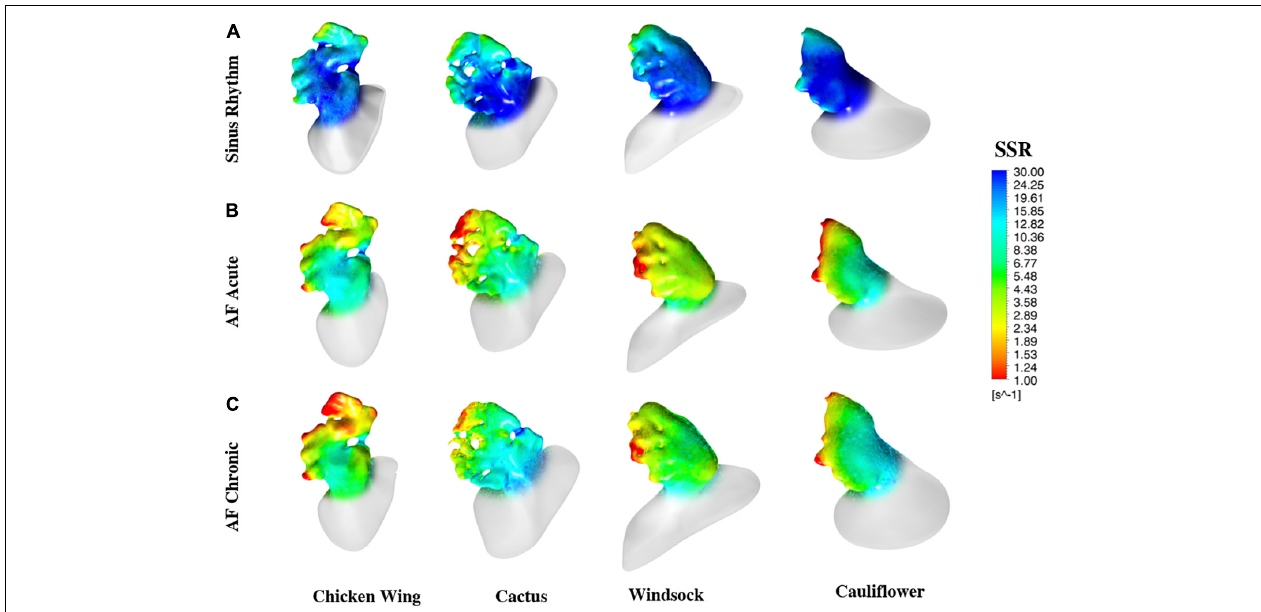
FIGURE 6 | Color maps of the maximum wall SSR at the instant of the cycle when they reach the maximum value, estimated for all models and all operating conditions.